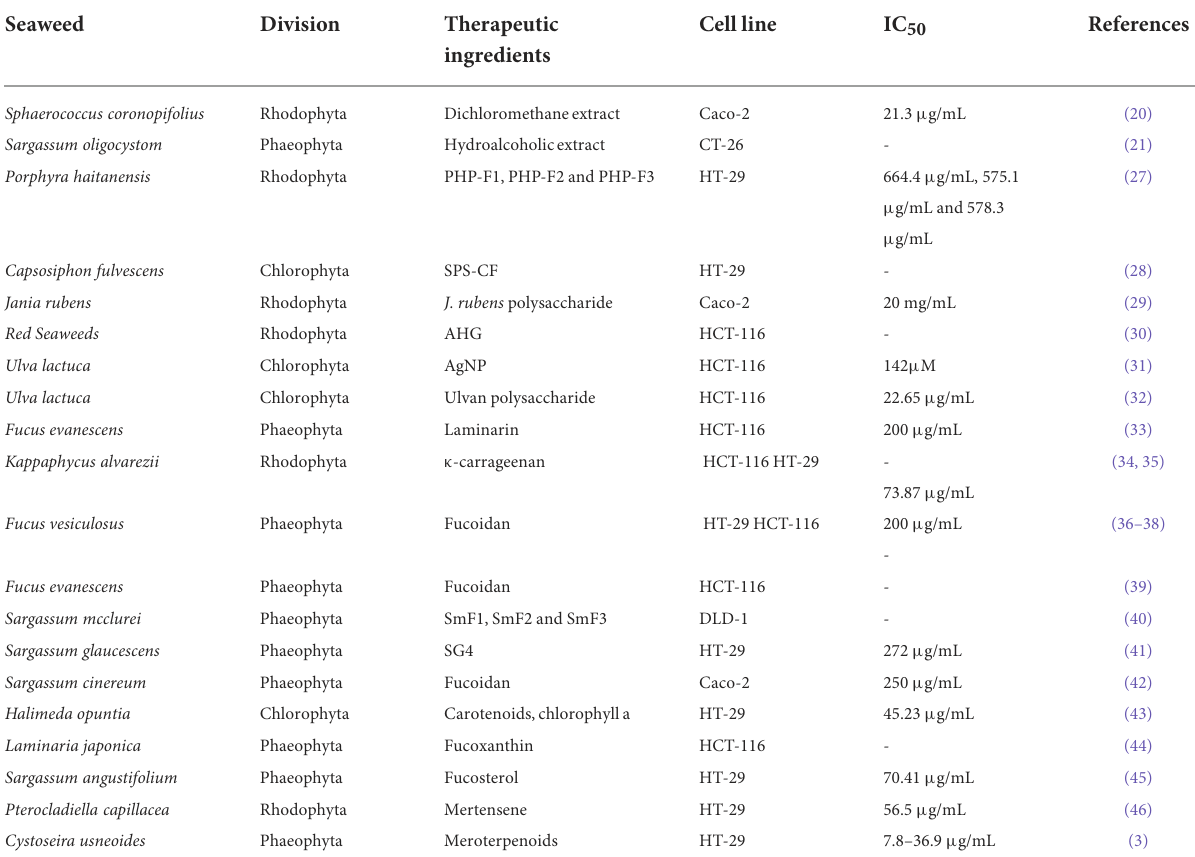
TABLE 1 The effects of active components isolated from seaweeds on colorectal cancer.